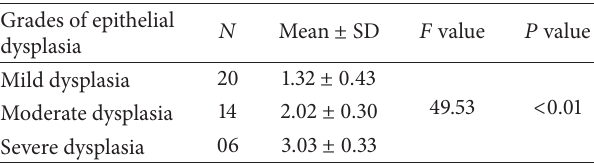
Table 1: Expression of podoplanin in oral leukoplakia (one-way ANOVA).